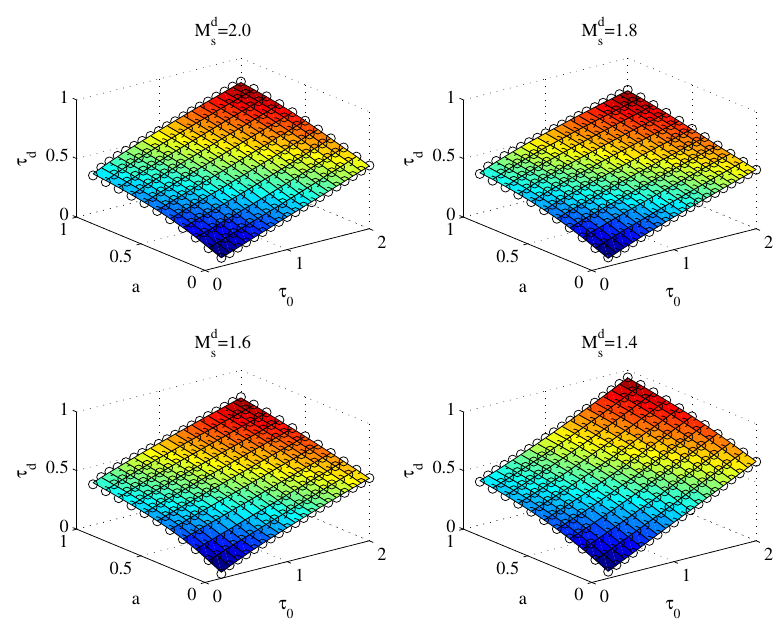
Figure 7. Calculated and approximated optimal τ d in the regulation